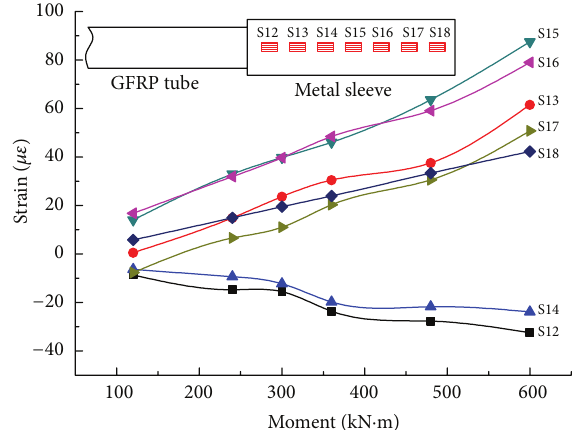
Figure 17: The relationship between the average longitudinal strain andbendingmomentofsteeljointC-1onthelowerchordofaGFRP- steel combined truss.